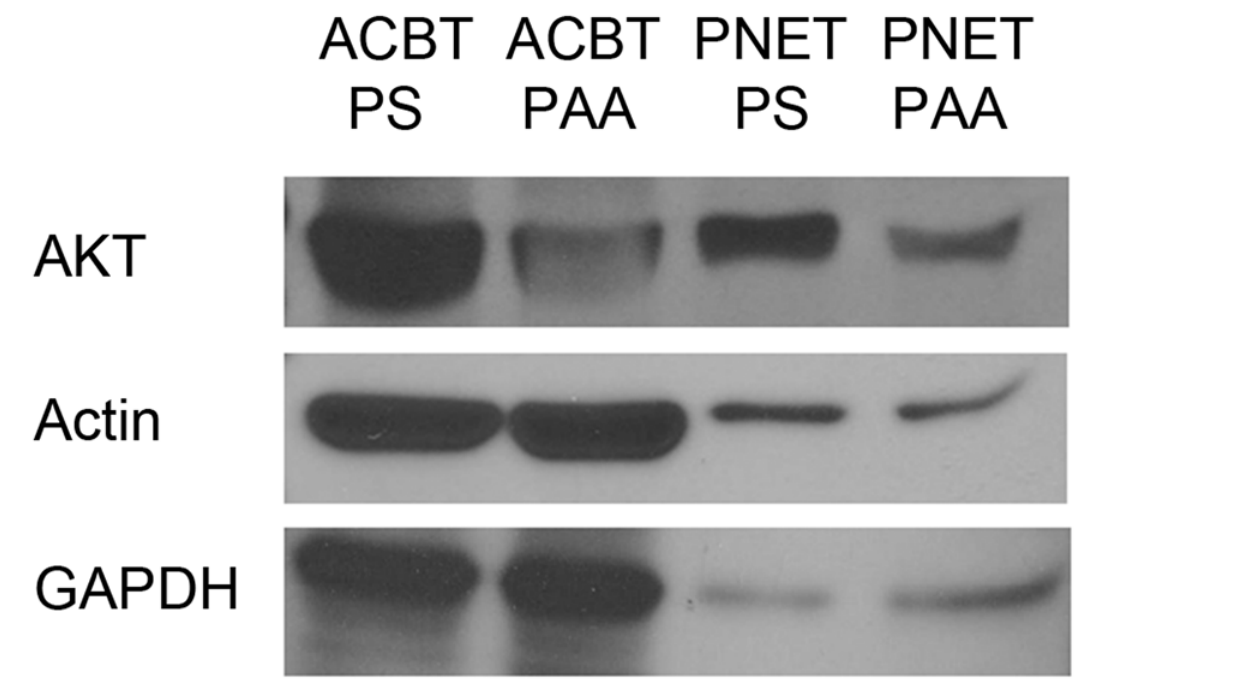
Fig 9. Western blot of ACBT and F3Y cell lysate for AKT on PS or PAA. GAPDH and Actin served as loading